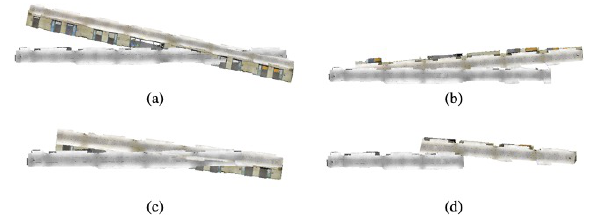
Figure 2. Different overlapping with the initial transformation. (a)ratio of overlapping is 95%, (b)ratio of overlapping is 75%, (c)ratio of overlapping is 50%, (d)ratio of overlapping is less than 30%. The point clouds in gray scale is target point clouds, while the point clouds in RGB is the source scale.